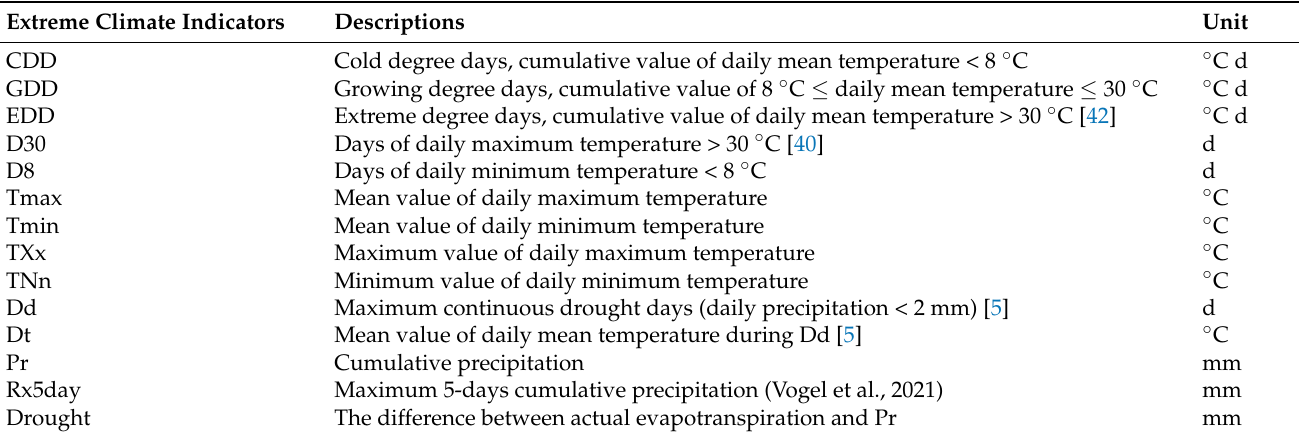
Table 1. Extreme climate indicators for machine learning framework during soybean growing